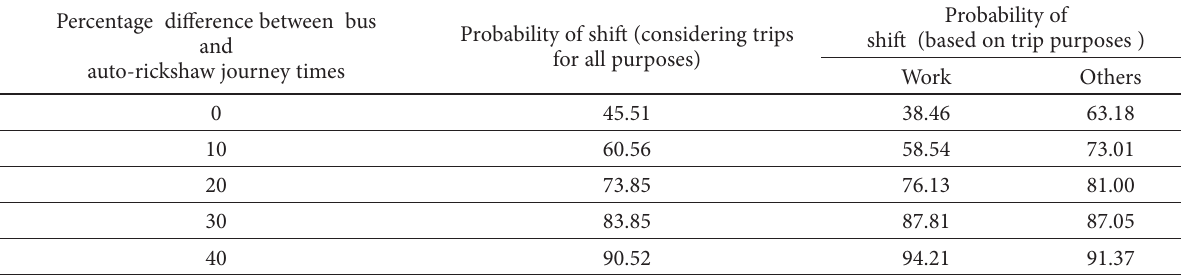
Table 7. Th e probability of the shift of auto-rickshaw users to the bus estimated by taking travel-time diff erence as the only causal variable Percentage diff erence between bus and